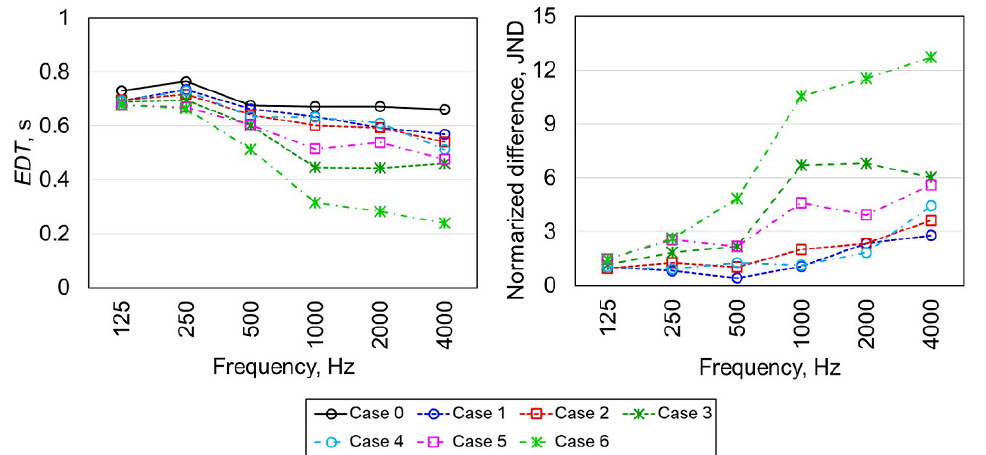
Figure 11. Spatially averaged EDT s for a small meeting room for cases 0–6 ( Left ) and differences from case 0 normalized by the JND value (5% [29]) ( Right ).